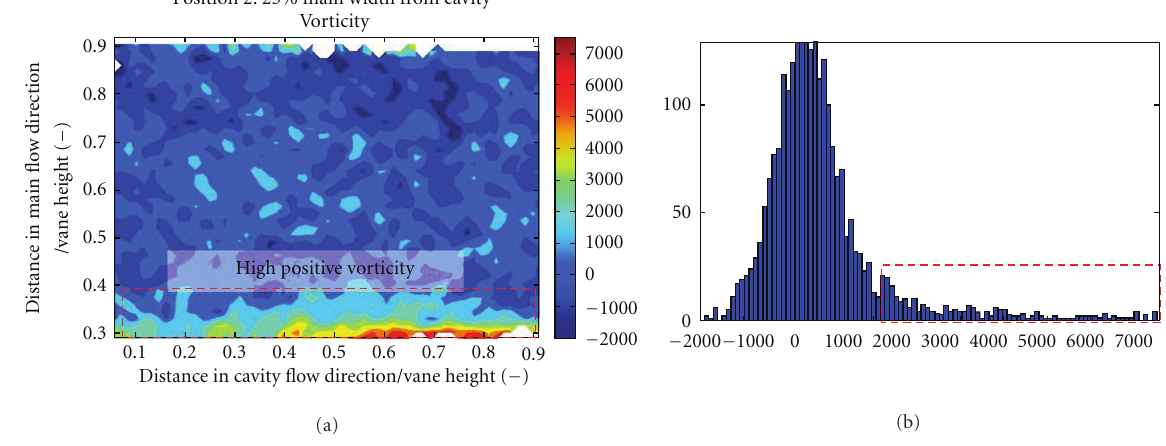
Figure 18: Vorticity plot showing counterclockwise flow rotation over the RVC (a); vorticity histograms (b), Position 2, 6mm from combustion chamber.